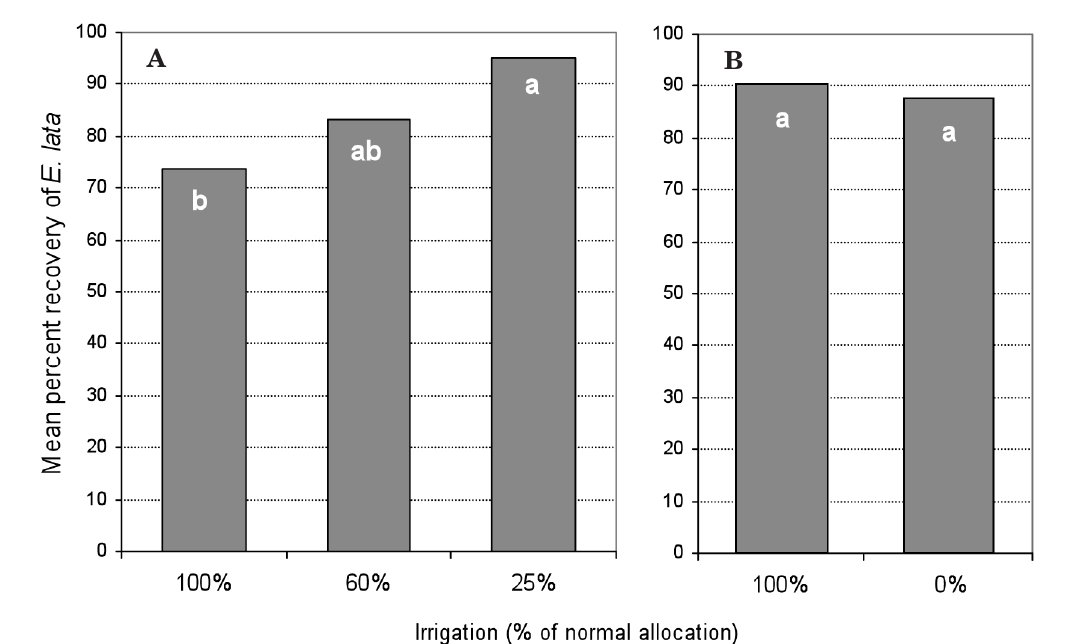
Figure 3. Effect of irrigation treatment (based on percentage of normal allocation in each year from 2006) on suscepti- bility of pruning wounds inoculated with E. lata in July 2008 on Vitis vinifera cultivars (A) ‘Cabernet Sauvignon’ in the Riverland and (B) ‘Ruby Cabernet’ in the Barossa Valley of South Australia. Mean percent recovery was based on as- sessments of treated canes collected in June 2009. Mean percentages with the same letter (a or b) are not significantly different (LSD; P